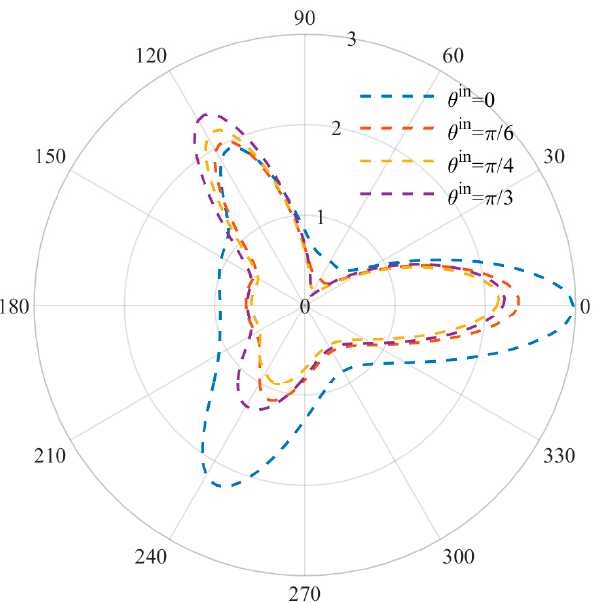
Figure 7. Distribution diagram of DSCF at different incident angles ( ka = 1).